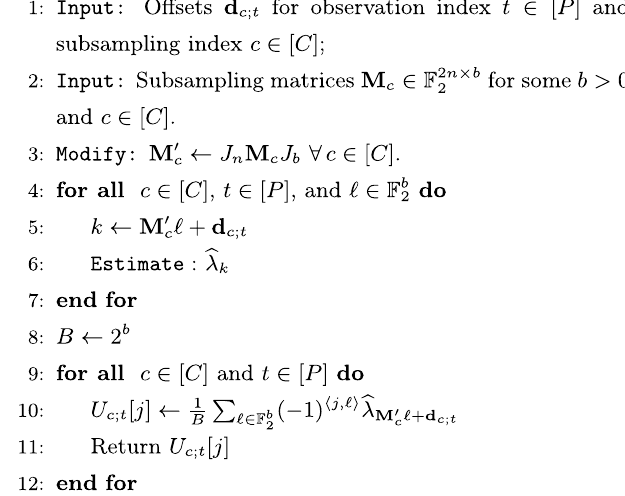
Algorithm 2. Subsampling and